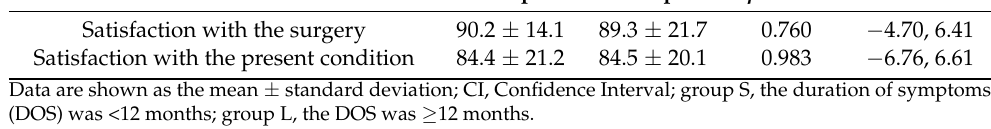
Table 4. The comparison of patient satisfaction scores. Group S Group L p Value 95% CI Satisfaction with the surgery 90.2 ± 14.1 − 4.70, 6.41 Satisfaction with the present condition 84.4 ± 21.2 84.5 ± 20.1 0.983 − 6.76,